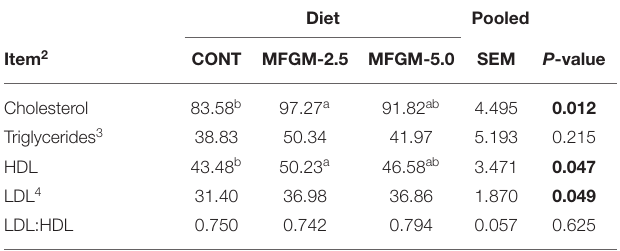
TABLE 2 | Concentrations of serum lipoprotein fractions 1 . Diet Pooled